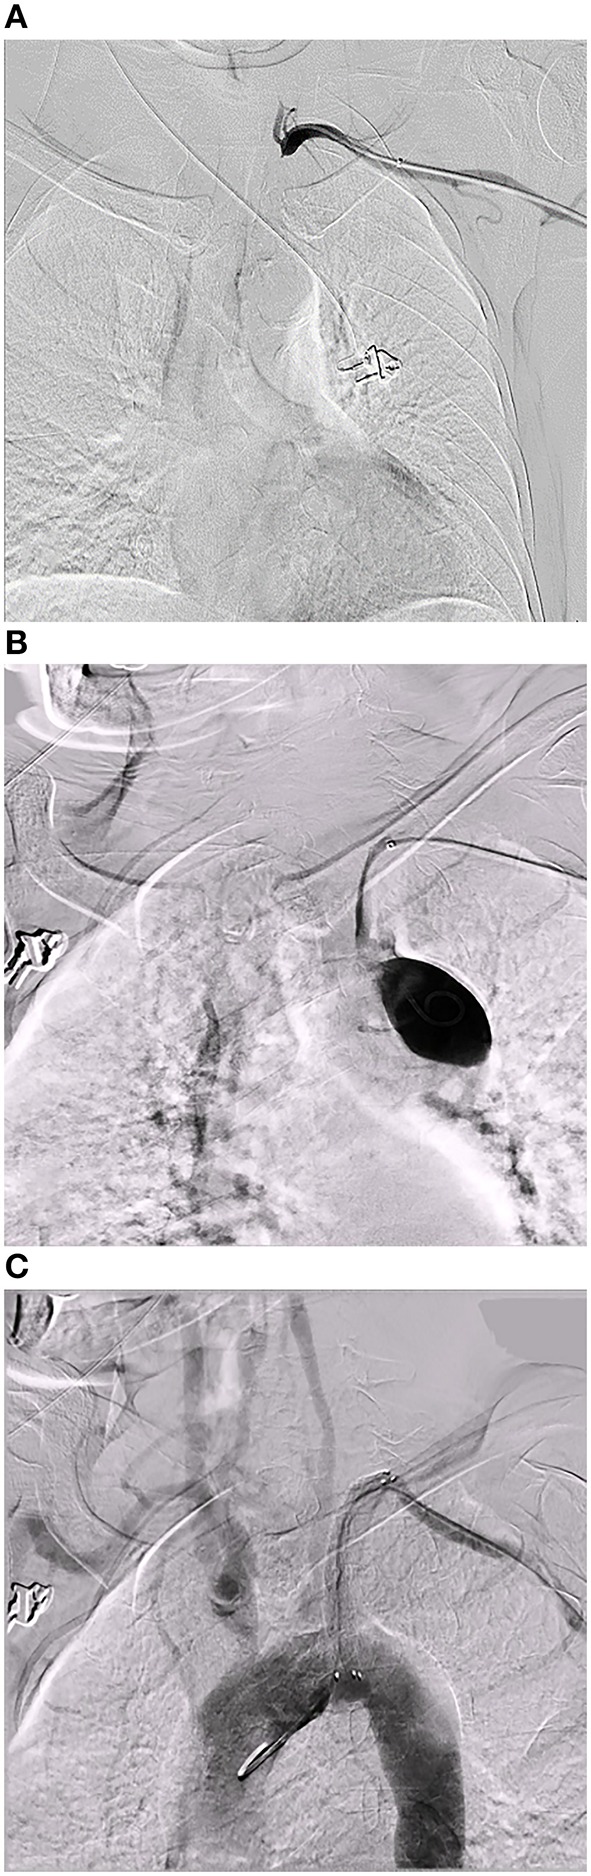
An arterial dissection. A 70 year-old male patient who presented with vertigo and left arm claudication for 2 years. CTA of the lower extremity showed bilateral iliac artery occlusion. (A) Angiography revealed a long segment occlusion at the beginning of the left subclavian artery. (B) After passing a guidewire through the lesion via the retrograde approach through the left brachial artery, angiography revealed an arterial dissection from the proximal segment of the left subclavian artery to the aortic arch. (C) A covered stent was implanted to treat the dissection, but the blood flow of the left vertebral artery was affected.